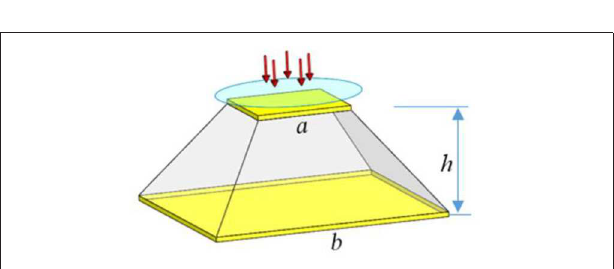
FIGURE 4 | IPMC pressure sensor with a gradient shape (Zhu et al., 2019) [reproduced from Zhu et al. (2019) with the permission of AIP Publishing].